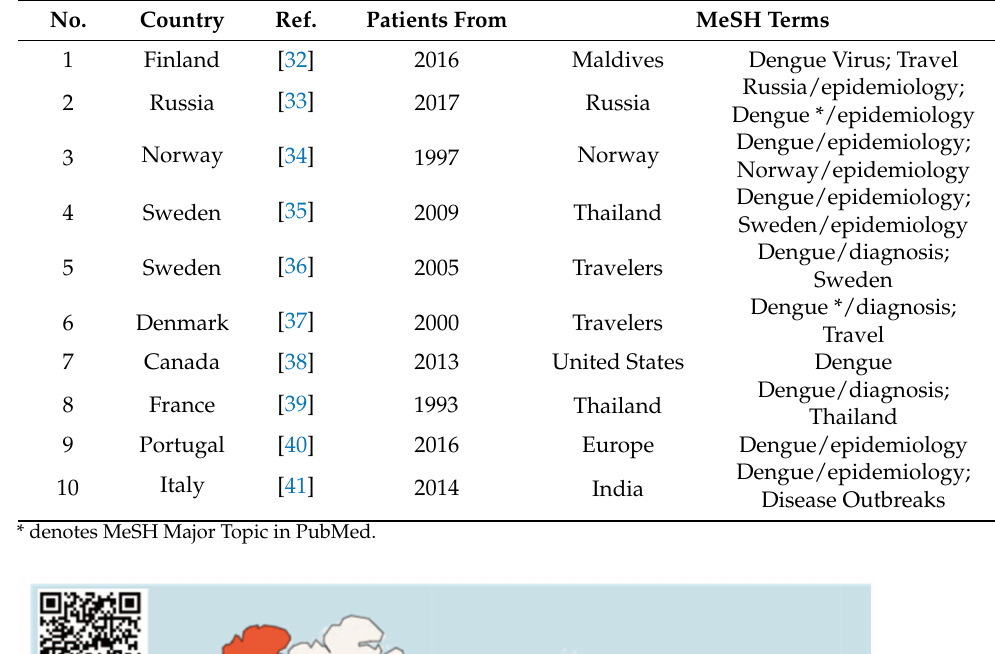
Table 1. Articles related to dengue outbreak (DO) outside the sub-tropical and tropical area (STTA). No.